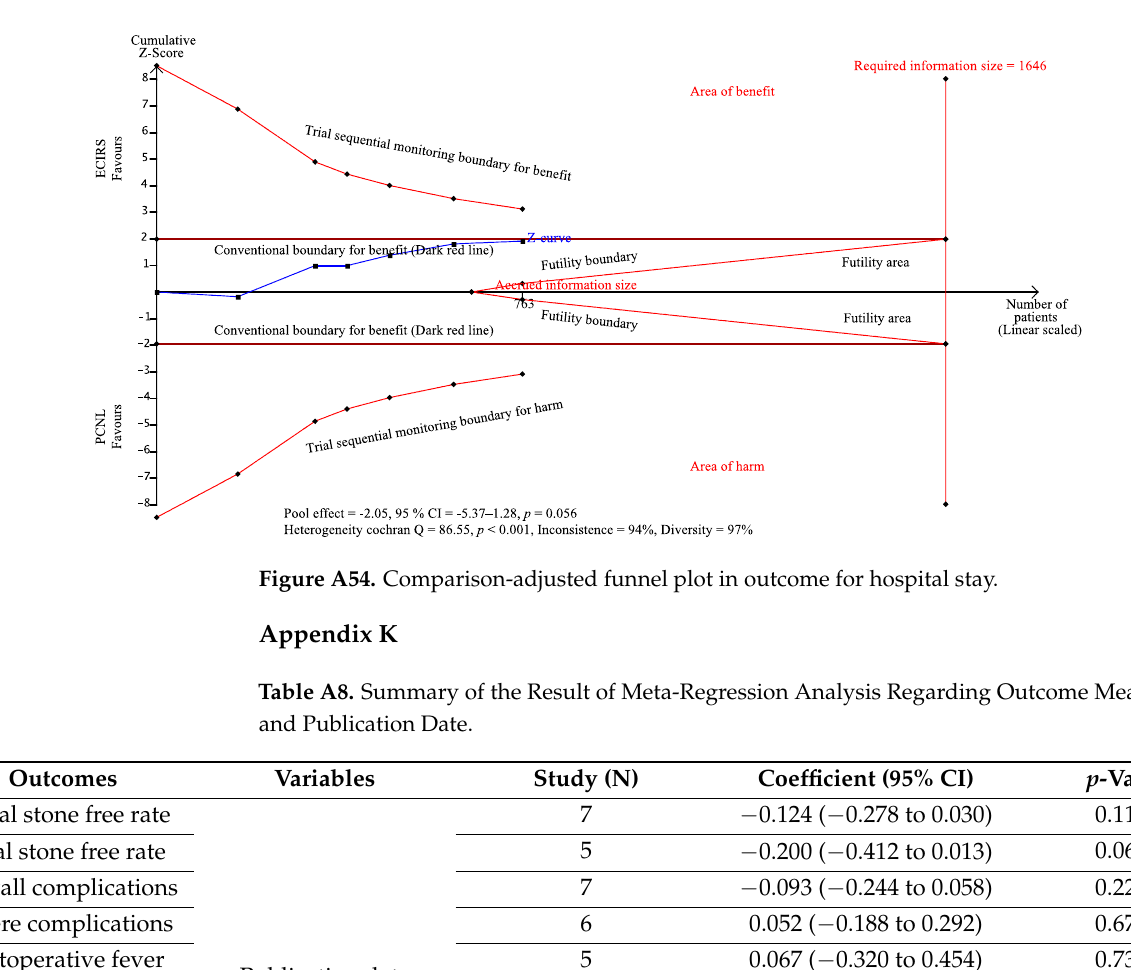
Figure A53. Comparison-adjusted funnel plot in outcome for operative time.